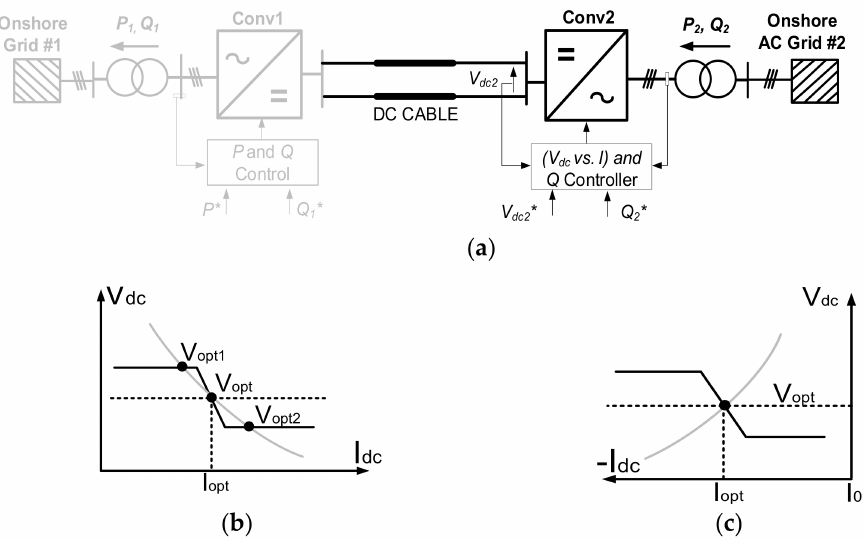
Figure 3. V - I control interactions. ( a ) Schematic. ( b ) Multiple crossing of two control characteristics. ( c ) No multiple crossing if sign of power reference is reversed.